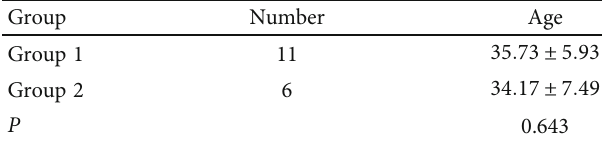
Table 1: Age information of the enrolled